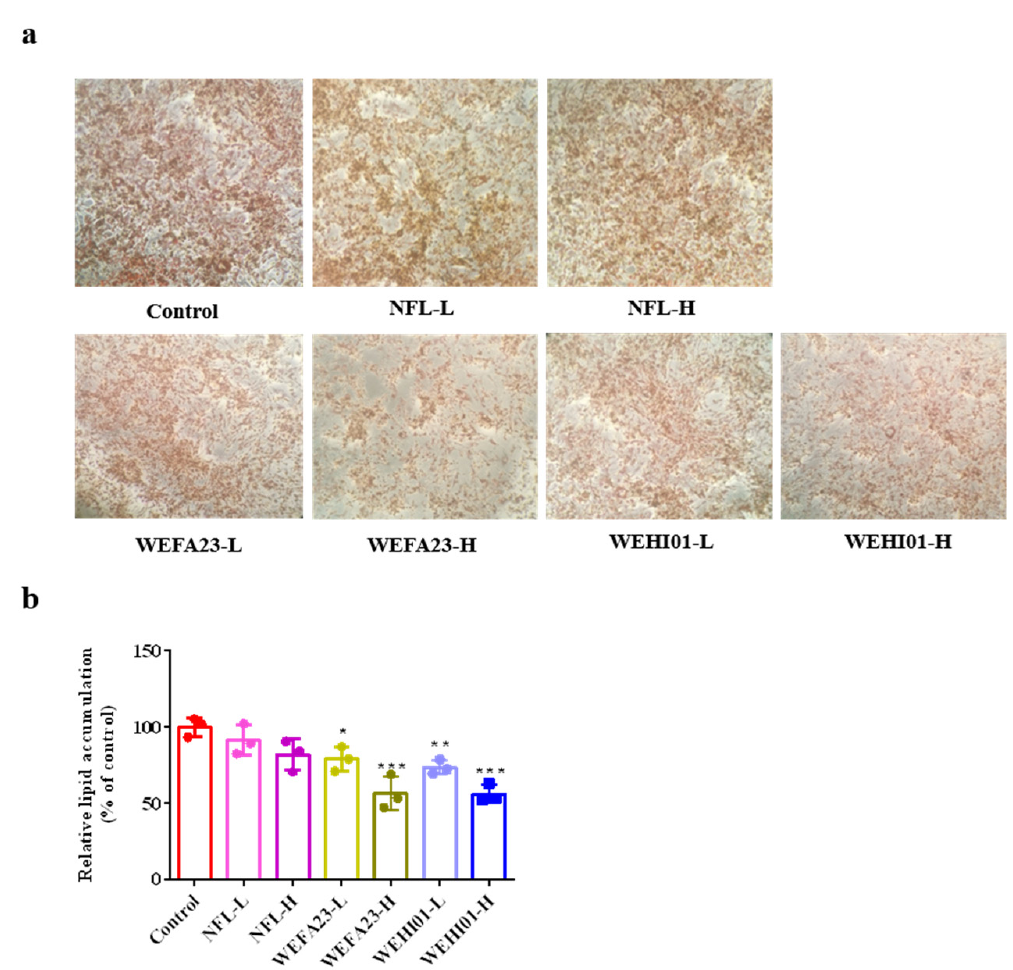
Figure 2. Effect of FLLS-WEFA23 and FLLS-WEHI01 on intracellular lipid accumulation in 3T3- L1 preadipocytes. ( a ) Representative images of lipid droplets which were measured by Oil Red O staining. Cells were treated with the Enterococcus -fermented lotus leaf supernatant (FLLS) and non-fermented lotus leaf supernatant (NFLLS) (10 × ). ( b ) Quantification of relative lipid content expressed as a percentage. Values were expressed as mean ± SD ( n = 3). * p < 0.05, ** p < 0.01, and *** p < 0.001 vs. Control.